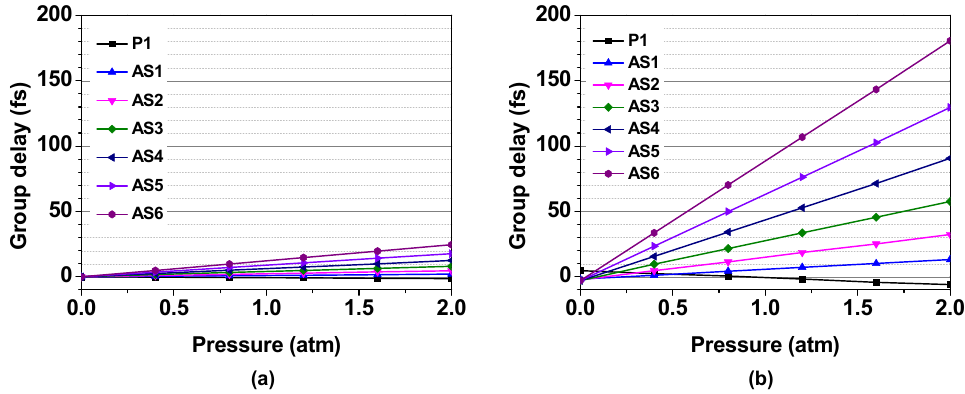
Figure 8. Group delay calculated for each emission against that of P2 for the gas cell ( a ) and the hollow fiber ( b ) at different gas